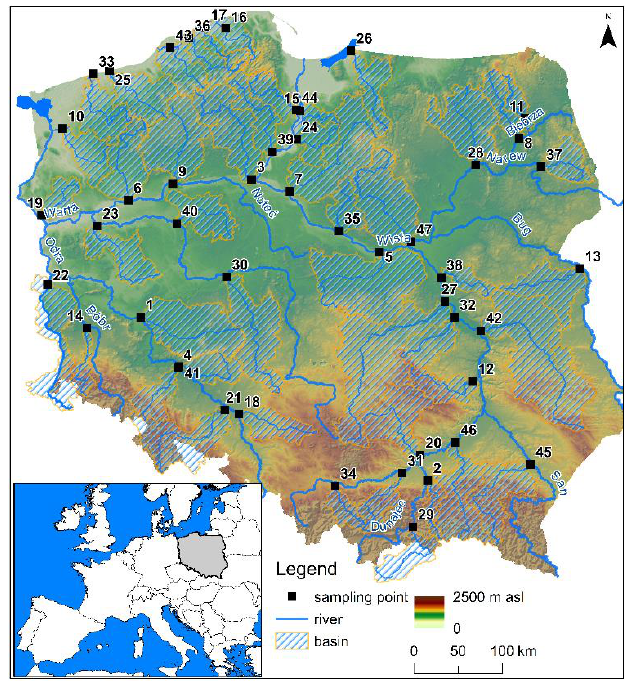
Figure 1. Study area location. The numbers of sampling points are listed in the Appendix A. Table 1. Chemical analysis technique and qualitative results